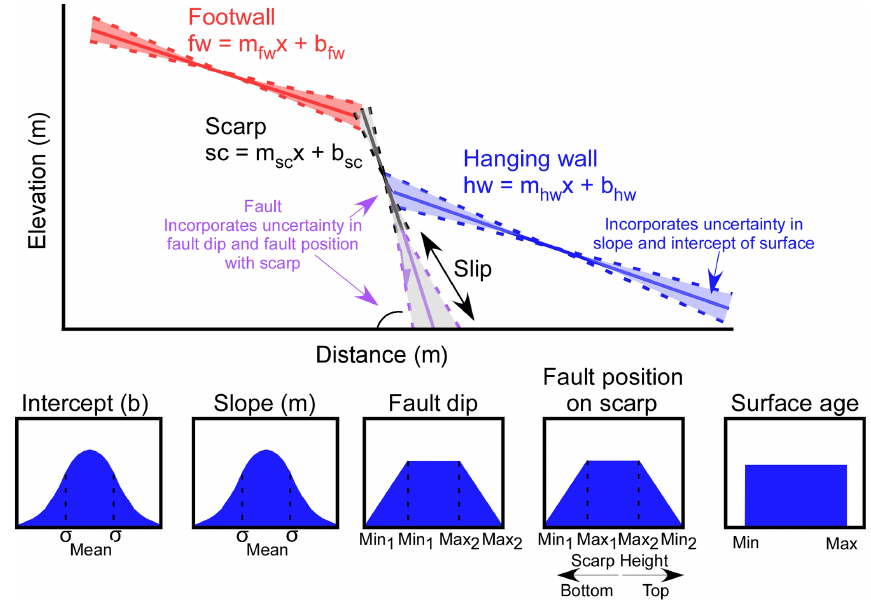
Figure 1. Slip statistics inputs. A schematic of inputs into the Monte Carlo Slip Statistics code, which include uncertainty in intercept, slope, fault dip, fault position on scarp, and the age of the geologic surface in question. For surface age, a uniform distribution is shown; however, the user could define a normal or trapezoidal distribution as well. Symbols used in the figure include slope ( m ), intercept ( b ), hanging wall (hw), footwall (fw), and position ( x ).